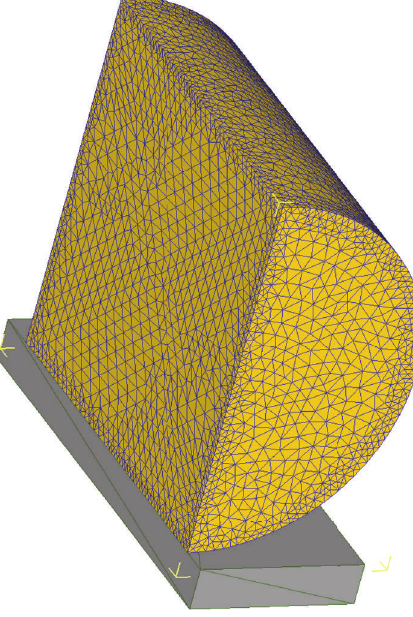
Figure 3: Diagram of transportation of billet from furnace to extruder.